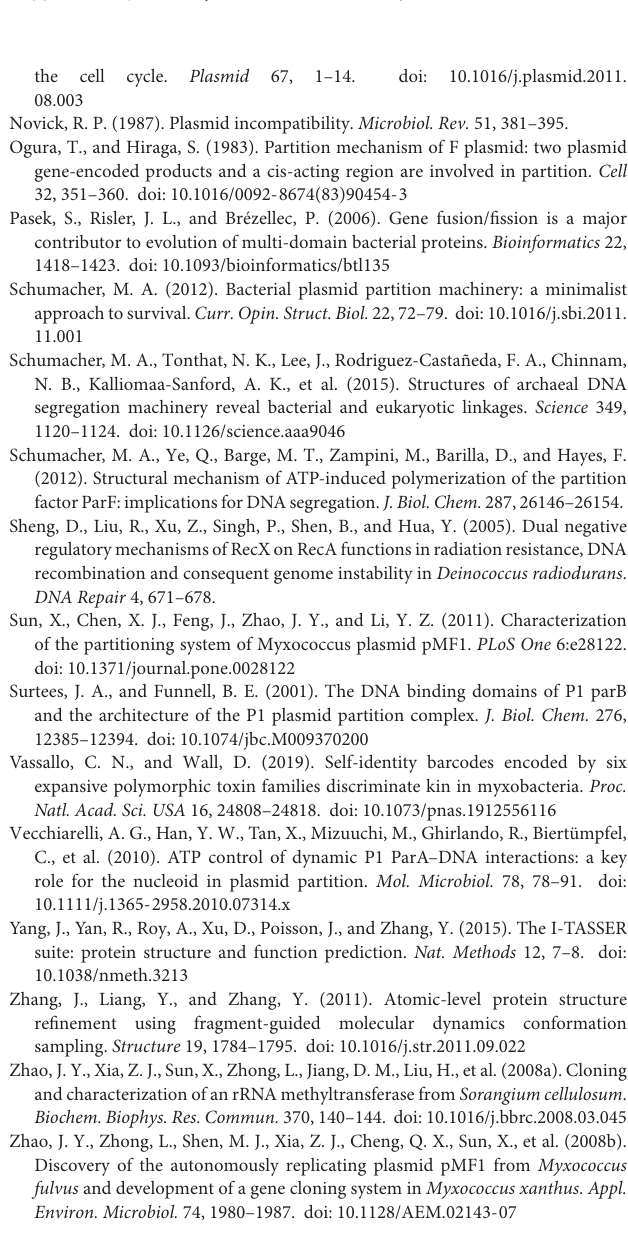
Supplementary Figure 9 | Alignment of ParCA and its homologous protein Bpet4565 from Bordetella petrii . Bpet4565 is a putative partition protein homologous to ParCA, found in the GenBank by the BLASTp. Their N-terminal structure is marked in blue box. Alpha helix structures in Bpet4565 (red box) and ParCA (orange box) are marked on their sequence. The identical amino acids are marked by asterisks, and similar amino acids are marked by dots.